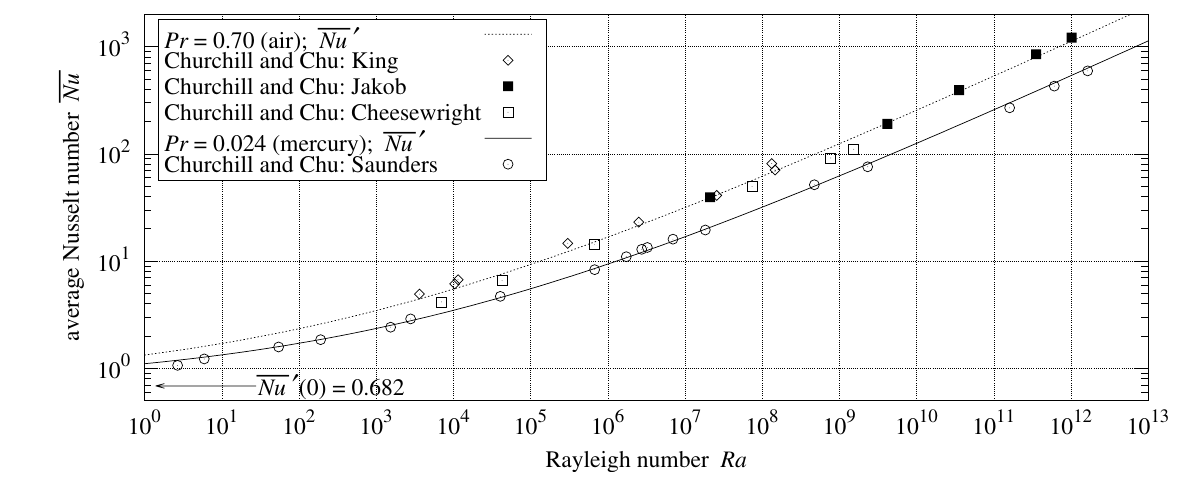
Figure 5. Heat transfer from vertical rectangular plate. Table 6. Heat transfer from vertical rectangular plate.